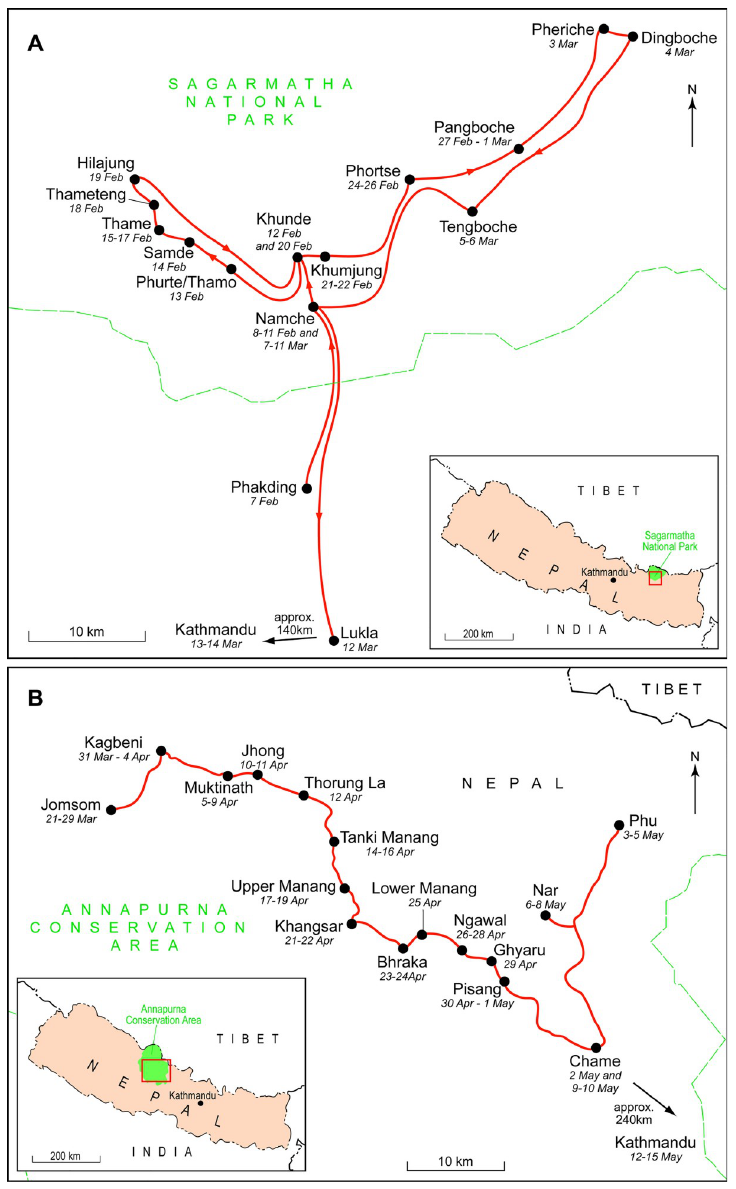
Fig 1. Study areas in Nepal showing areas and dates sampled. (A) Sagarmatha National Park. (B) Annapurna Conservation Area. Locations outside of study sites, and the dates visited, shown for illustrative purposes